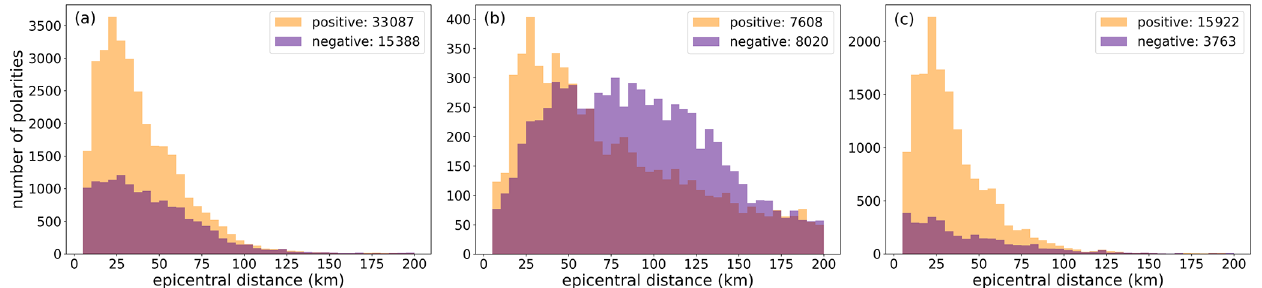
Figure C1. Distribution of the positive and negative P-wave polarities for earthquakes with M > 2 . 5 in the Apennine region (41–44 ◦ N and 9–15 ◦ E) (a) ; (b) as in panel (a) but for earthquakes outside the Apennines; (c) as in panel (a) but filtered by back azimuth along the NE–SW directions, corresponding to the intervals 15–105 ◦ and 195–285 ◦